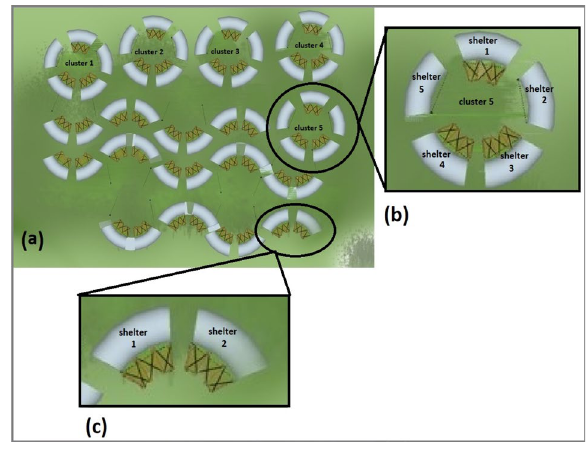
Fig. 7 Internal planning of residential zones of the camp